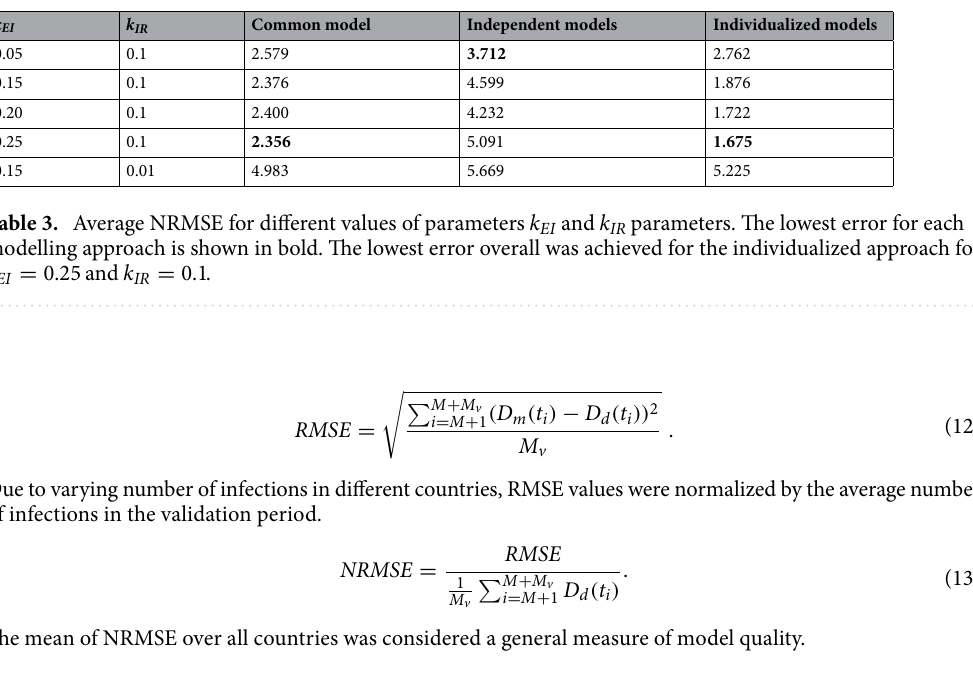
k EI k IR Common model Independent models Individualized